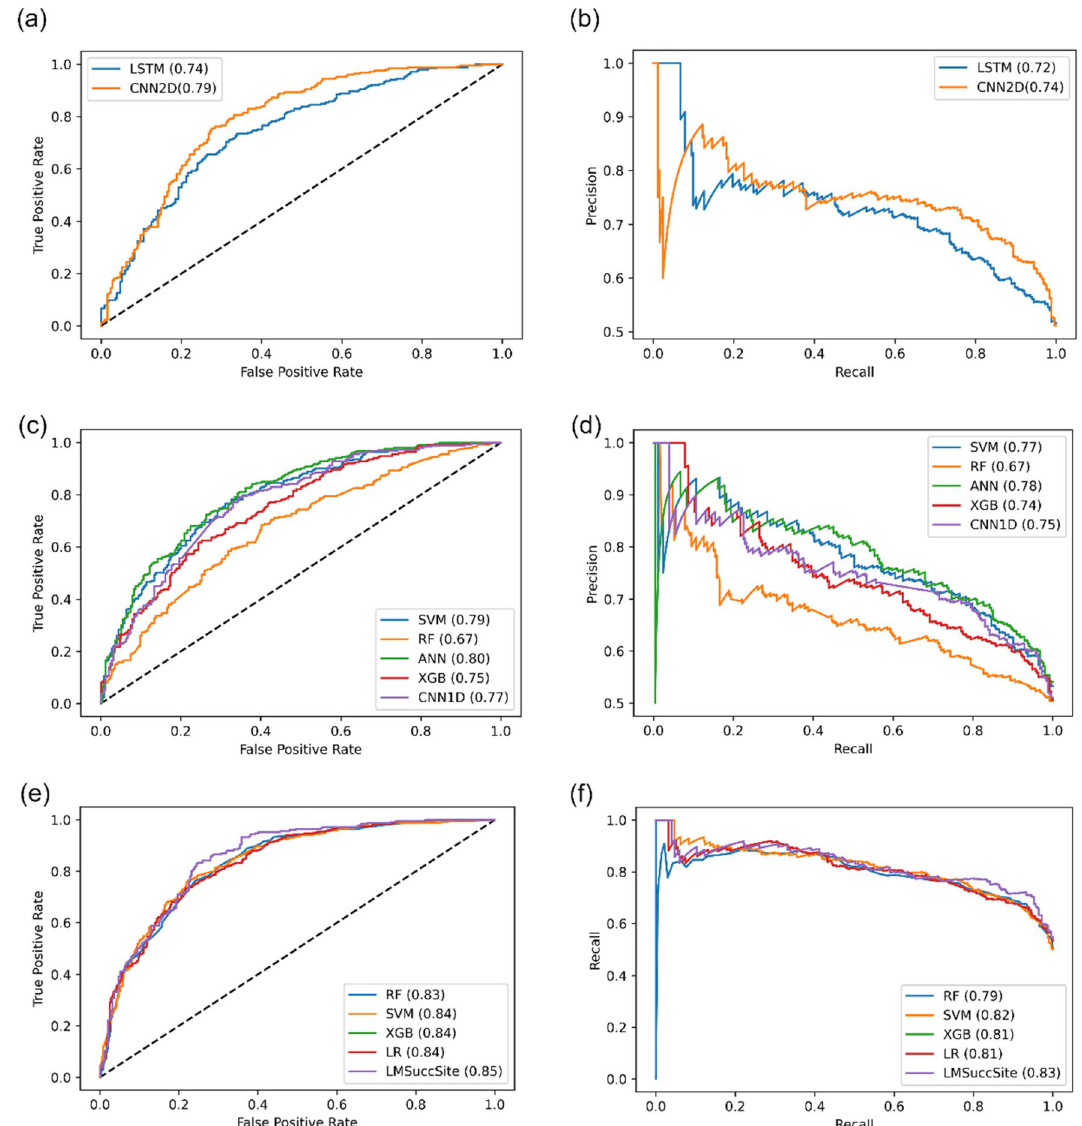
Figure 4. ROC (Receiver Operating Characteristic) curve and PR (Precision Recall) curves with AUC (Area Under Curve) for different models explained in Tables 3, 4. ( a ) ROC curves for supervised embedding-based models ( b ) PR curve for supervised embedding based models ( c ) ROC curves for Prot-T5 based models ( d ) PR curves for Prot-T5 based models (e) ROC curves of different meta classifier for combined models ( f ) PR Curves of different meta classifier for combined